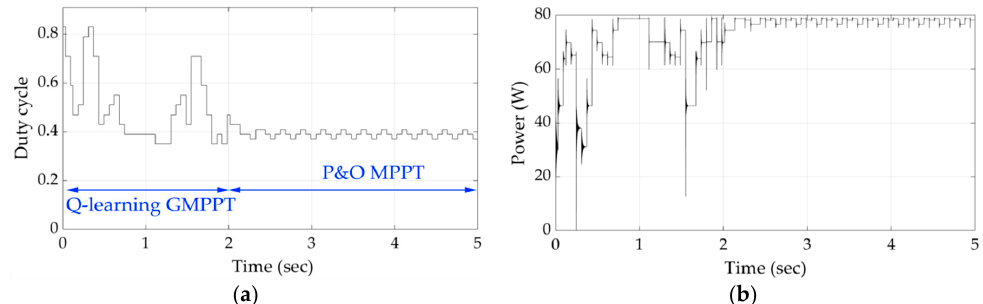
Figure 12. Results during execution of the proposed Q-learning-based GMPPT process for shading pattern 5: ( a ) duty cycle versus time and ( b ) PV array output power versus time.